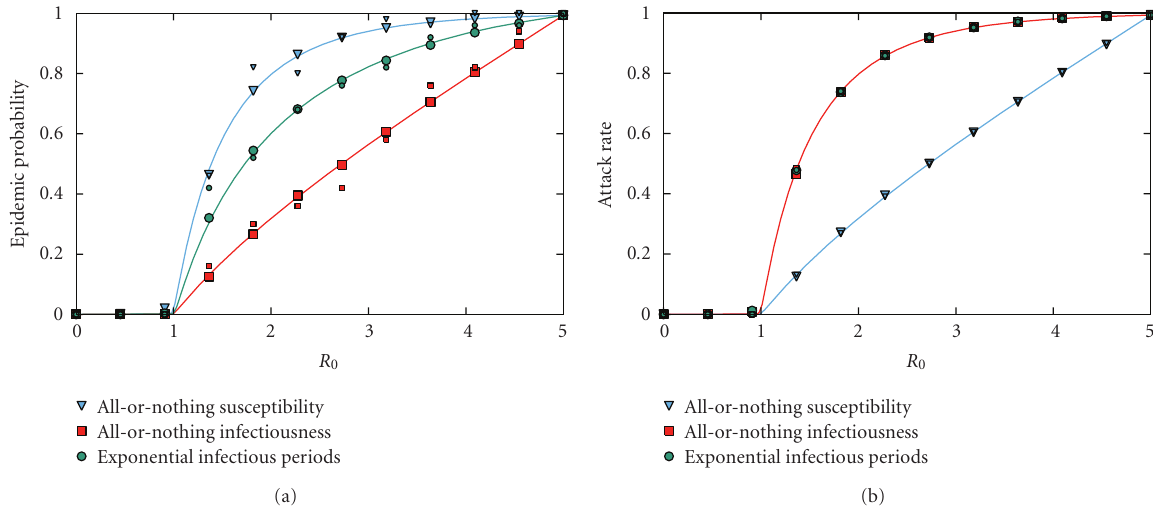
Figure 4: A comparison of the predictions from a single EPN with 50 simulations for three di ff erent epidemic processes on an Erd˝os-R´enyi network of 50,000 nodes with average degree 5. The EPN results (large symbols) closely match the calculated predictions in the asymptotic limit. The simulated results (small symbols) compare well for size but poorly for probability. Generating an EPN is a much more e ffi cient numerical method for estimating the probability of a major epidemic than